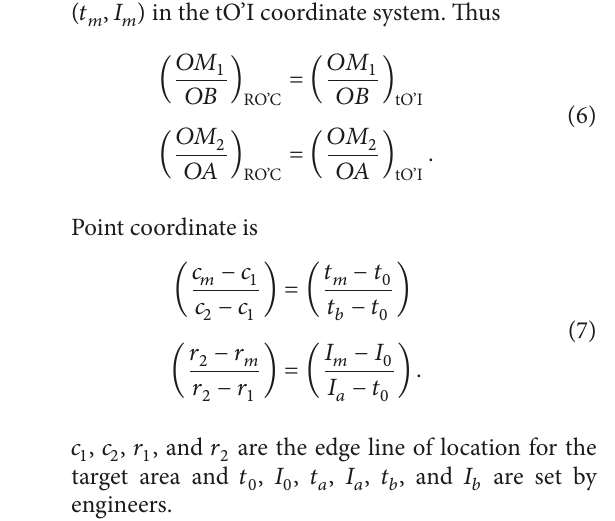
turnout operation current curves and improve the